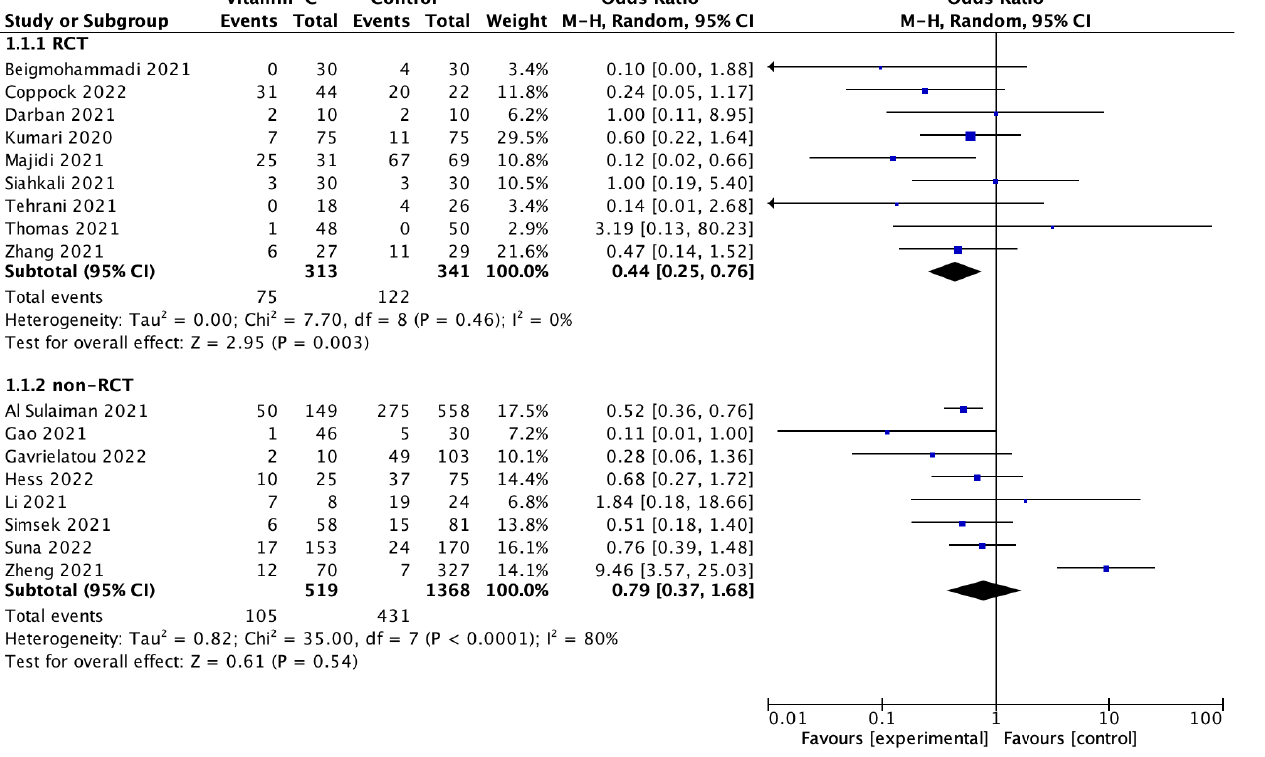
Figure 3. Forest plot of in-hospital mortality among COVID-19 patients with and without vitamin C supplementation. The center of each square represents the odds ratios for individual trials, and the corresponding horizontal line stands for a 95% confidence interval. The diamonds represent pooled results.[32 – 37,39 – 48,50]